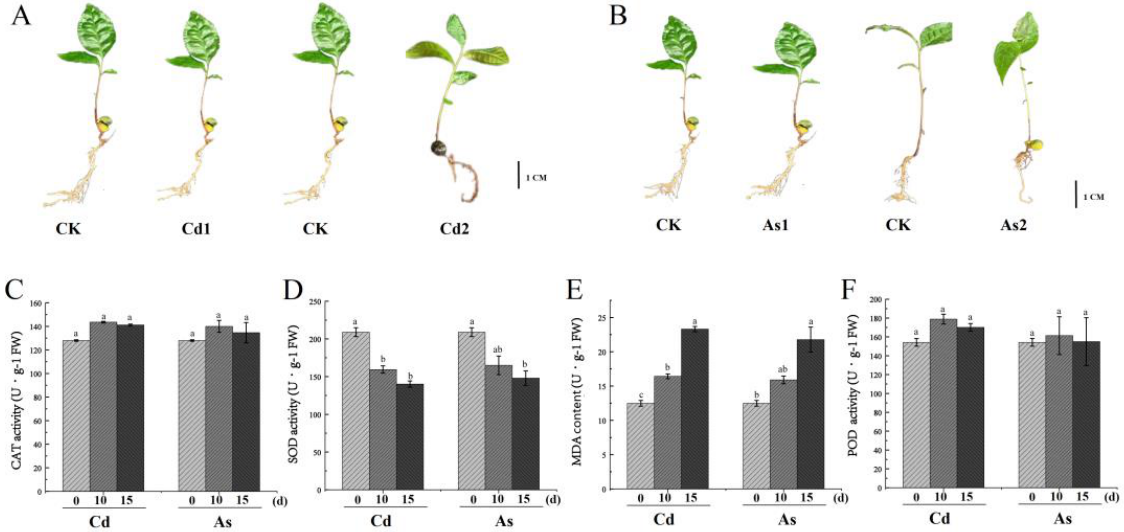
Figure 1. The effect of heavy metal Cd and As on phenotype, antioxidant enzyme activities, and MDA content. ( A ) The phenotypic difference in roots between Cd treated-tea plants and the control group; ( B ) The phenotypic difference in roots between As treated-tea plants and the control group. ( C – F ) Antioxidant enzyme activity and MDA content in tea roots between Cd/As treated-tea plants and the control group; ( C ) CAT activity; ( D ) SOD activity; ( E ) POD activity; ( F ) MDA content. Three biological replicates were obtained for each data point. Data were presented as means ± Sd ( N = 3). Different letters above bars indicate significant differences between the Cd-treated C. sinensis roots and the control group ( p < 0.05).